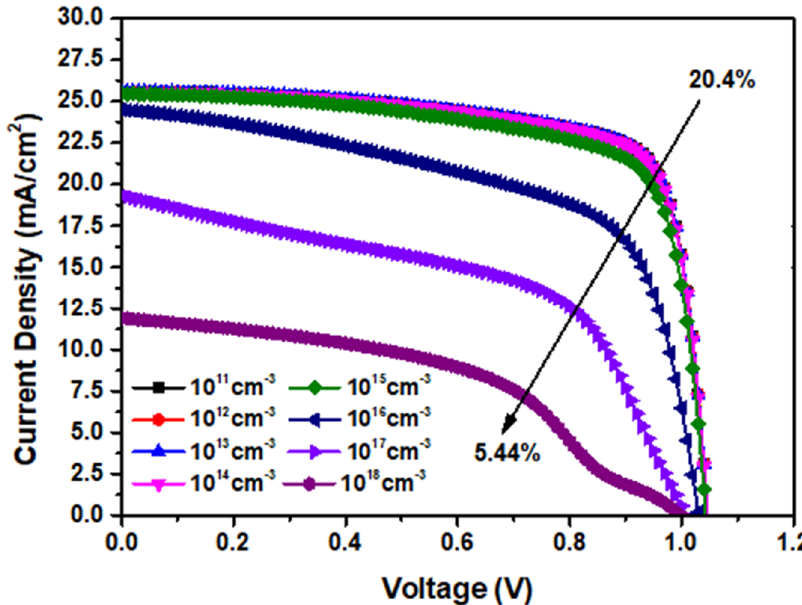
Figure 9. Current density–voltage ( J – V ) curves for various PAL defect densities.